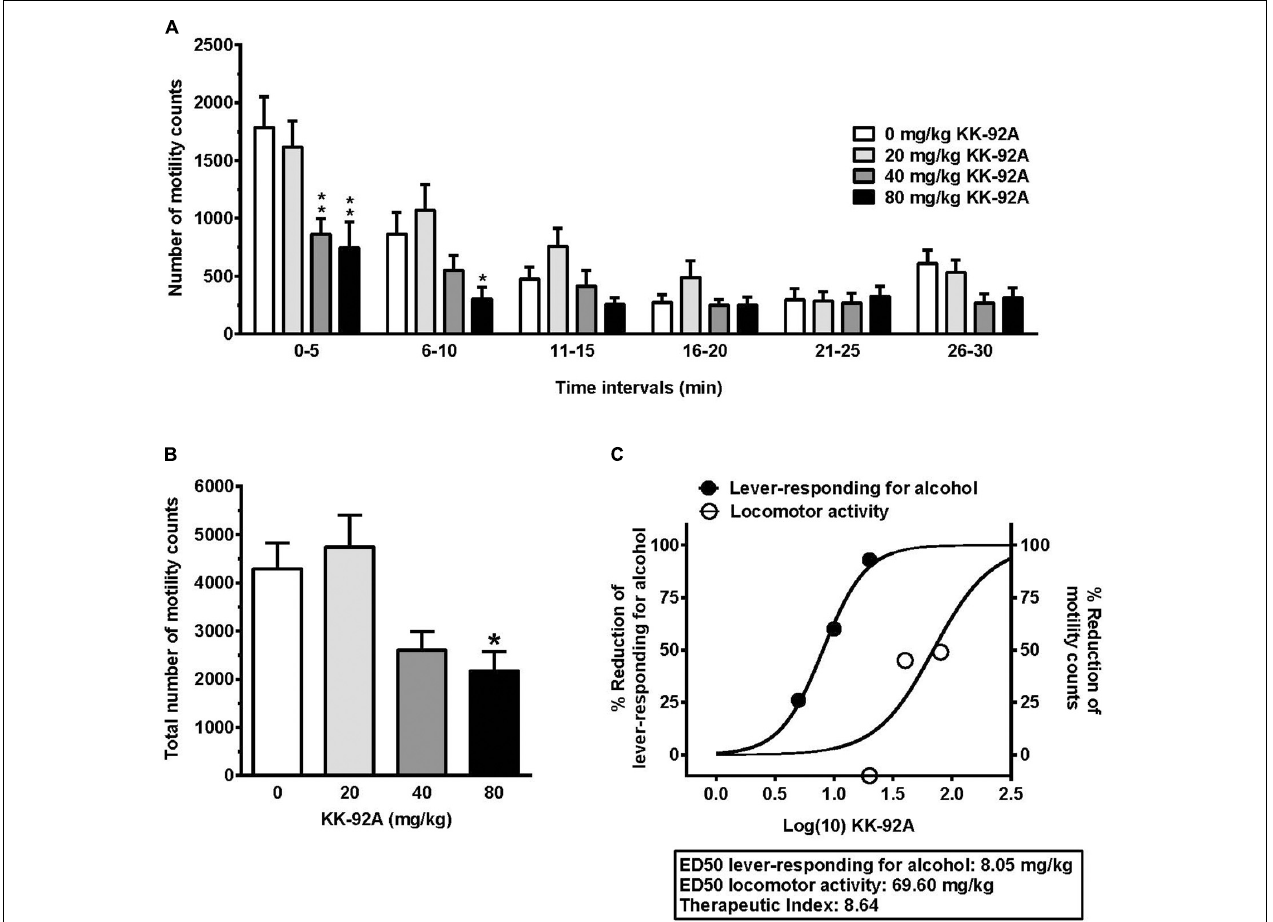
FIGURE 6 | Effect of acute treatment with the positive allosteric modulator of the GABA B receptor, KK-92A, on spontaneous locomotor activity in female Sardinian alcohol-preferring rats (A,B) and dose-response curves and calculated ED 50 s for KK-92A-induced hypomotility and reducing effect on alcohol self-administration (C) . Rats were initially trained to lever-respond for oral alcohol (15% v/v, in water) [Fixed Ratio (FR) 5 (FR5)] and water (FR1) in daily 30-min self-administration sessions. Once lever-responding had stabilized, rats were exposed to the locomotor-activity session. Specifically, rats were exposed to a computer-operated, photocell-equipped cage, to which they were unfamiliar. KK-92A was administered intraperitoneally 30 min before the start of the locomotor-activity session. The locomotor-activity session lasted 30 min. The measured variable was the total number of counts (photocell breaks) recorded automatically by the apparatus. In panel (A) , data are expressed as mean ± SEM of number of motility counts in six 5-min time intervals in n = 9–10 rats; * P < 0.05 and ** P < 0.0001 in comparison to the rat group treated with 0 mg/kg KK-92A (Tukey’s test). In panel (B) , data are expressed as mean ± SEM of total number of motility counts over the entire locomotor-activity session in n = 9–10 rats; * P < 0.05 in comparison to the rat group treated with 0 mg/kg KK-92A (Tukey’s test). Data depicted in panel (C) are plotted as (i)% reduction in spontaneous locomotor activity [data from panel (B) ] and (ii)% reduction in lever-responding for alcohol under the FR5 schedule of reinforcement (data from Figure 1A ). EC 50 s were calculated by 4-parameter (top plateau , bottom plateau , middle or logEC 50 , and slope) logistic non-linear regression from sigmoidal dose-response curves using GraphPad 6 (GraphPad Software; La Jolla, CA, United States); bottom and top constraint equal to 0 and 100%, respectively, was used for curve fitting. Therapeutic index (TI) was calculated according to the following formula: “Hypomotility” ED 50 /“Reduction of lever-responding for alcohol” ED 50